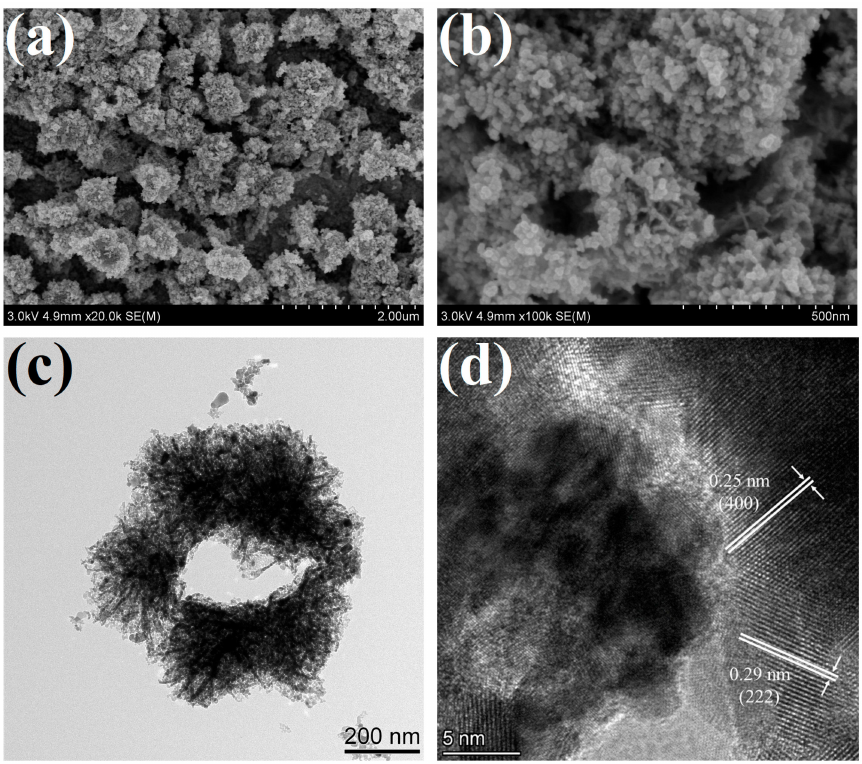
Figure 2. SEM and TEM images of 1 at% Pd/Pt-In 2 O 3 : ( a ) low-resolution SEM image, ( b ) high- resolution SEM image, ( c ) TEM image, ( d ) HRTEM